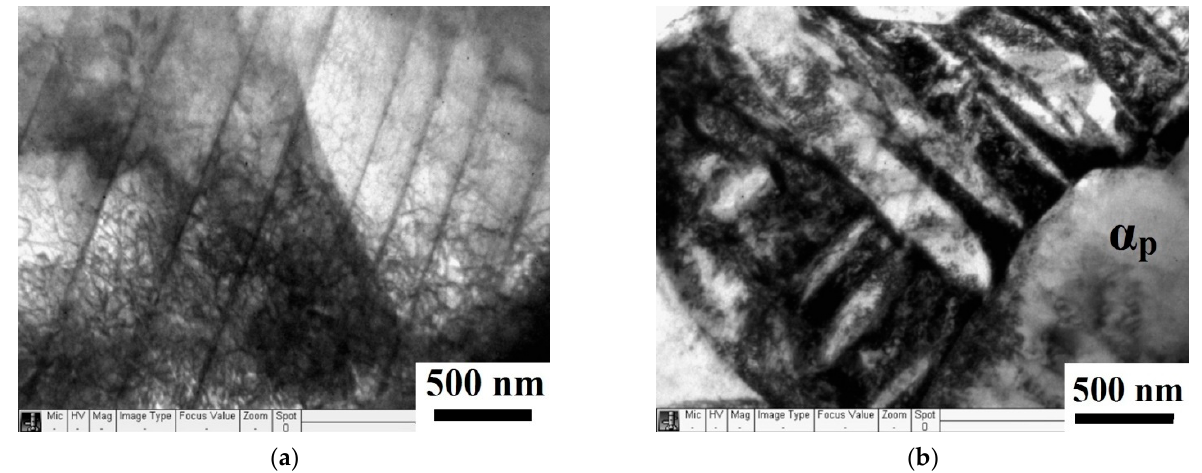
Figure 5. Microstructure of the near-surface layer of a Ti-6Al-4V sample with CG structure after PEP: dislocation substructure in the primary α p ( a ); ( α + β ) lamellar structure ( b ). TEM.